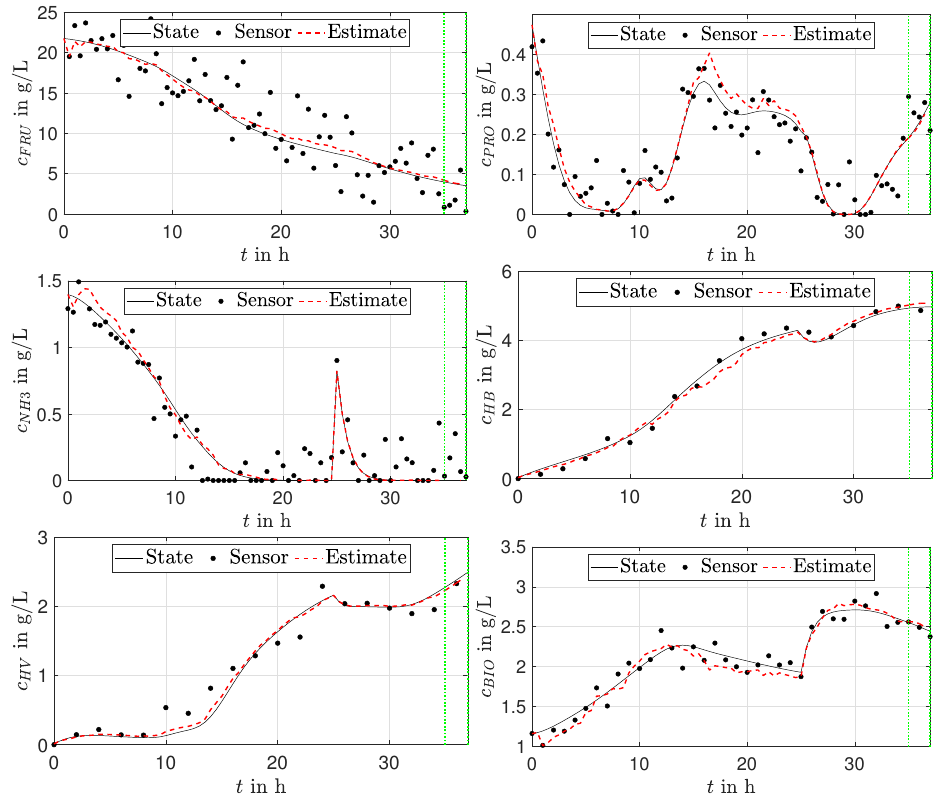
Figure 4. State estimation for microbial PHA production: Accurate